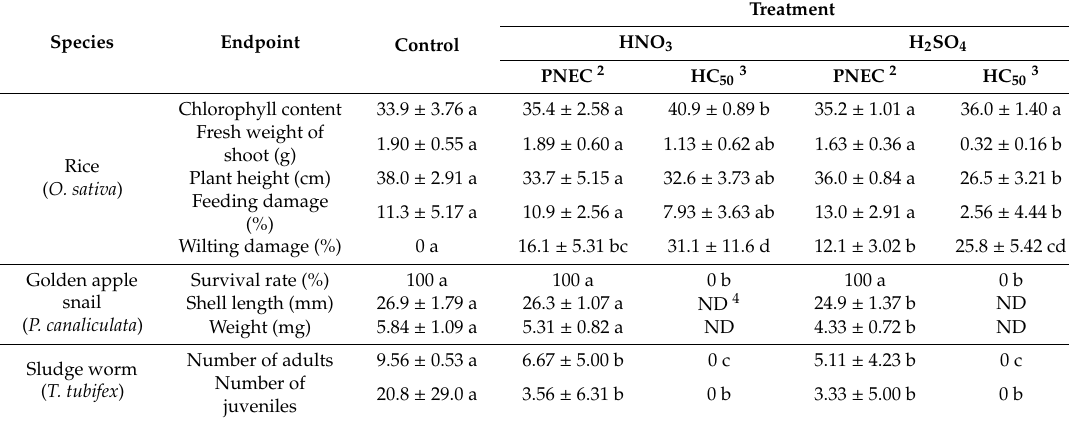
Table 1. Results 1 of measured endpoints of three test species ( O. sativa , Pomacea canaliculata , and Tubifex tubifex ) at the 4th